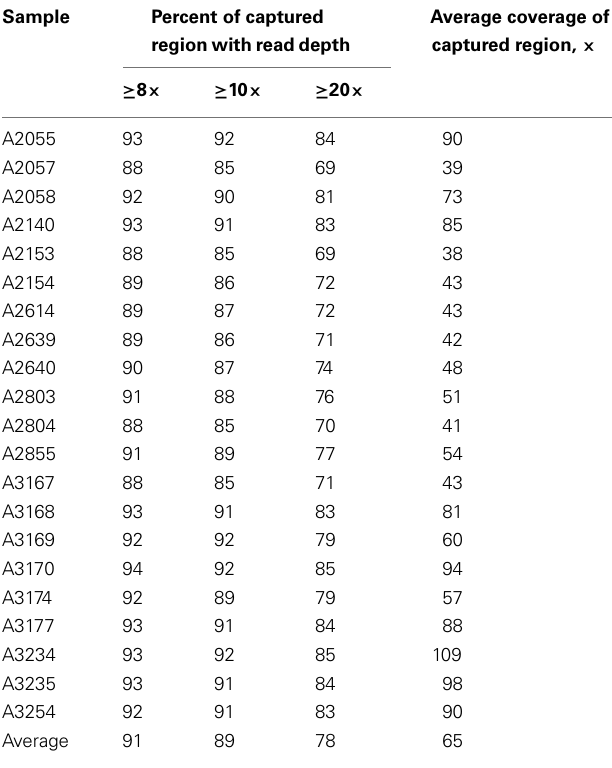
Table 2 | Basic statistics of exome sequencing per